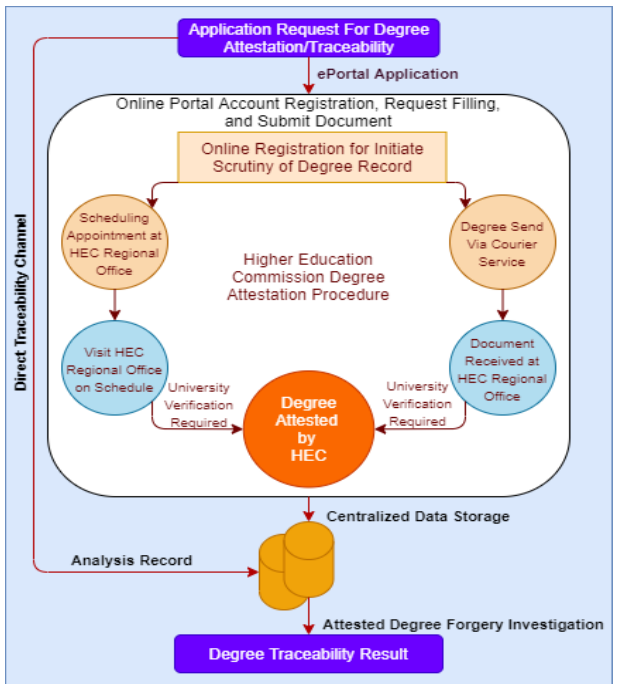
Figure 1. Current semiautomated higher education commission degree attestation and traceability architecture.